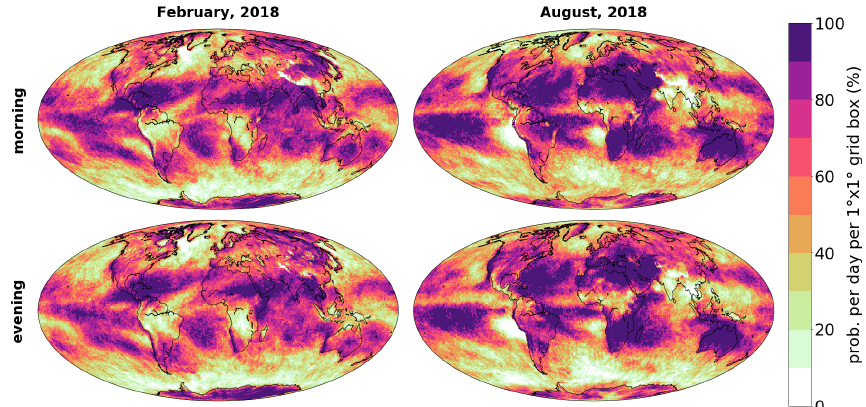
Figure 3. Similar to Fig. 2 but for the probability of having at least one valid IASI observation (measurement that passed the cloud filter and EUMETSAT quality checks) per overpass and 1 ◦ × 1 ◦